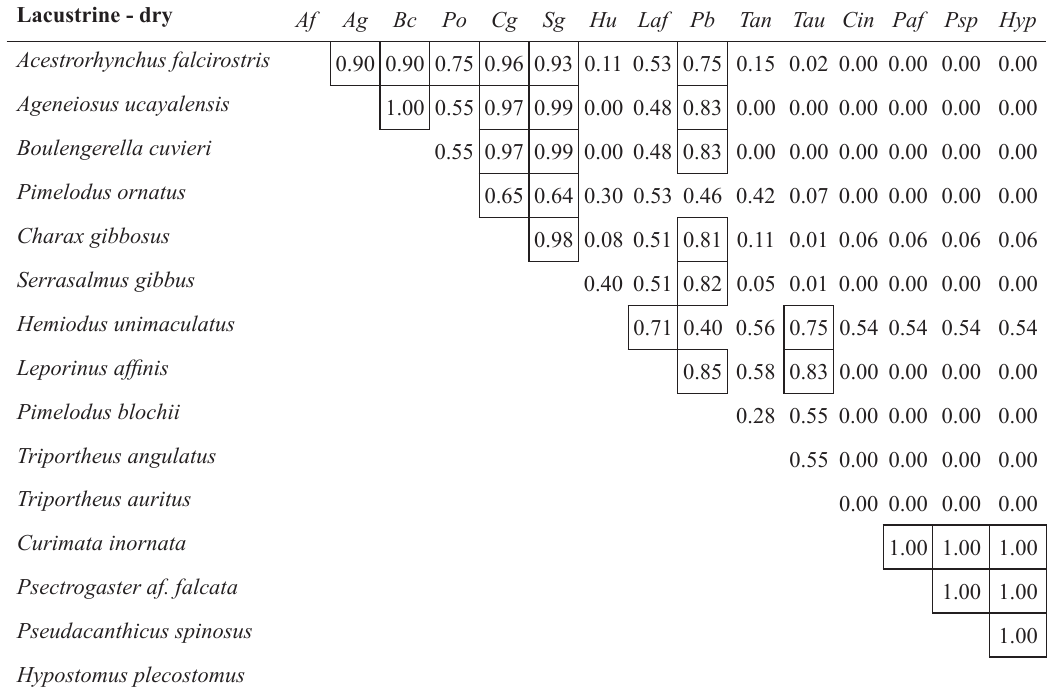
Niche overlap between pairs of species analyzed from Lacustrine area of Coaracy Nunes Dam, Ferreira Gomes – Amapá (AM-Brazil).